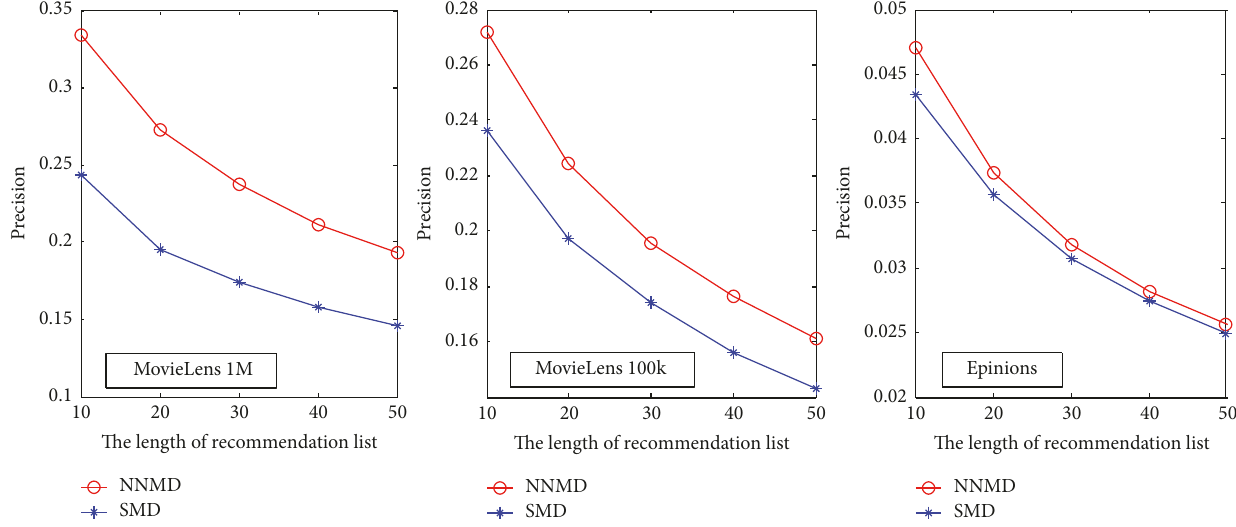
Figure 4: The precision of NNMD and SMD algorithm in MovieLens 100k, MovieLens 1M, and Epinions under different length of recommendation list. The parameters for the NNMD algorithm are 𝑁 = 50 and 𝛼 = 0.9 in MovieLens 100k and MovieLens 1M while they are 𝑁 = 10 and 𝛼 = 0 in Epinions.